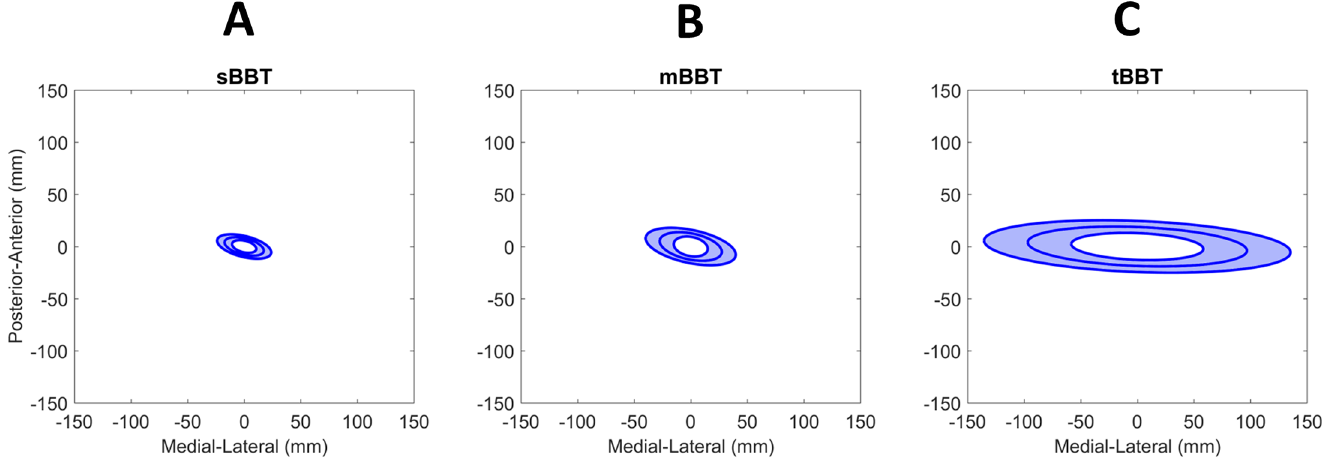
Fig 8. Center of Pressure. Average CoP 95% confidenceellipsefor subjects(n = 16) performingthe (A) sBBT, (B) mBBT, and (C) tBBT. The y-axis and x-axis show the zero-mean CoP in the anterior-posterior and medial-lateral directions, respectively.